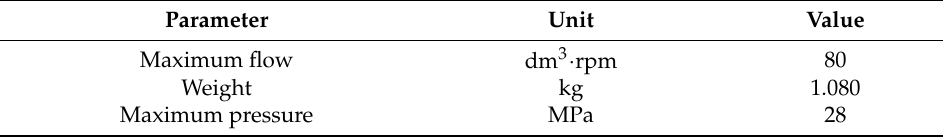
Table 10. Technical parameters of the throttle valve VRB 90 (RV).